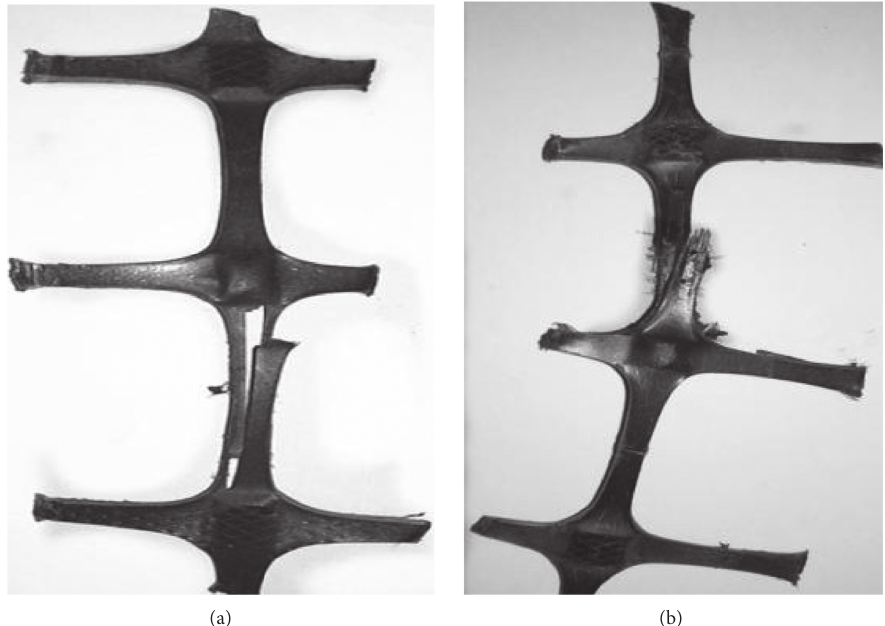
Figure 2: Tensile fracture diagram of test piece. (a) Original geogrid. (b) Aging geogrid.